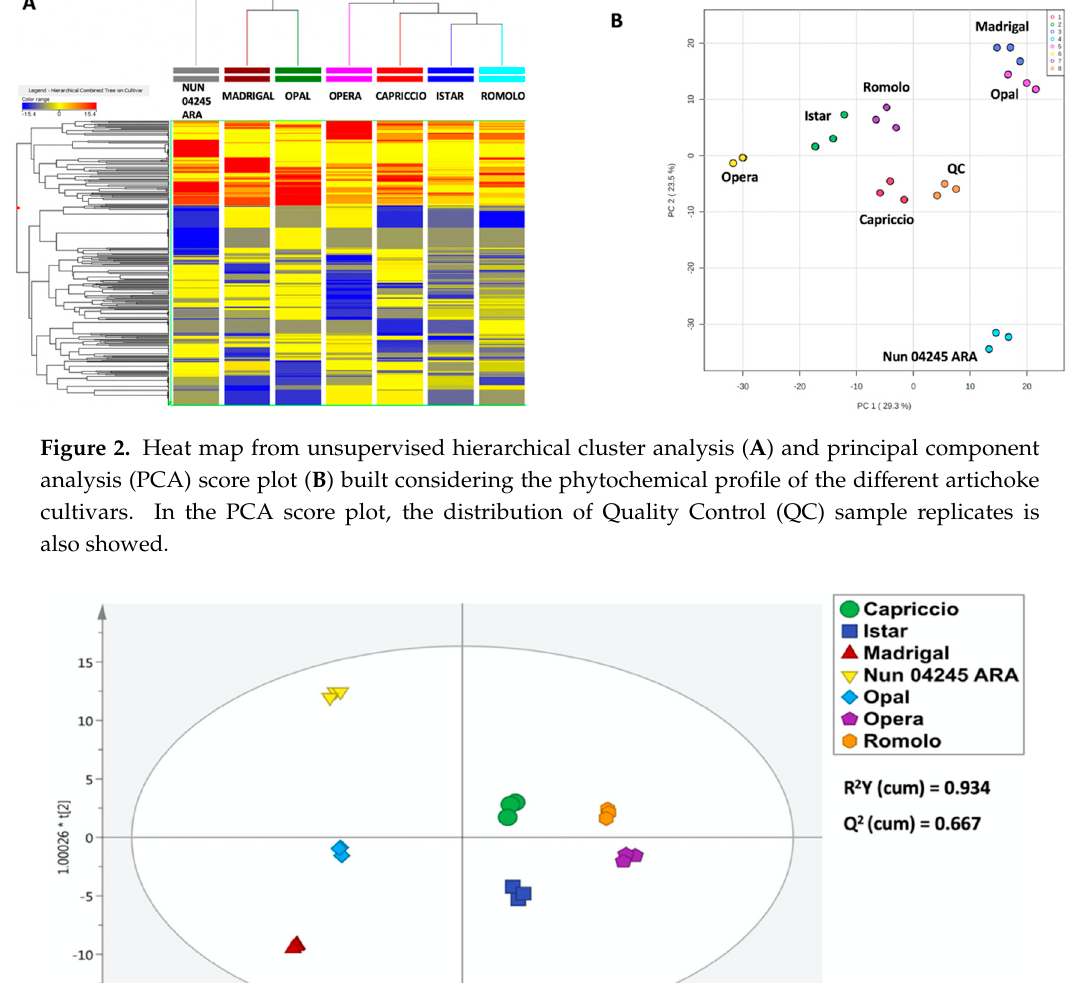
Figure 3. Orthogonal projection to latent structures discriminant analysis (OPLS-DA) built considering the phytochemical profile (from UHPLC-QTOF) of the different artichoke cultivars.